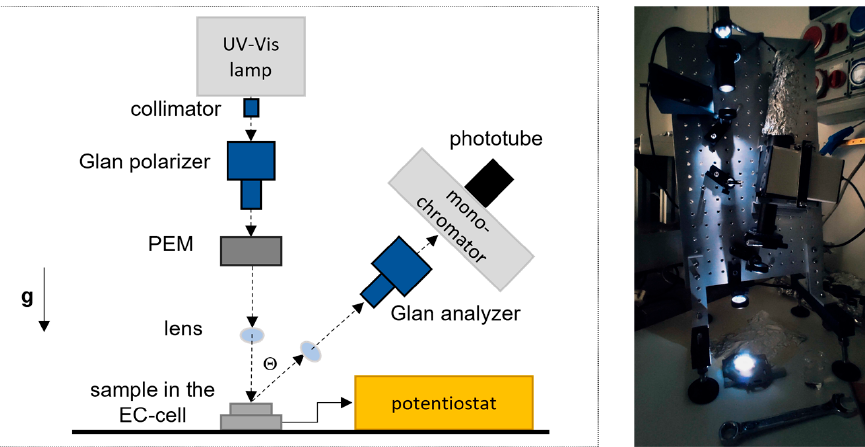
Figure 5. Sketch and picture of the experimental set-up used to couple RAS with the electrochemical measurements. The light beam illuminates the sample from the top-aperture of the EC cell, placed on the table. Reflected light is collected within an angle of about 4° from the impinging beam direction (see the main text for details).